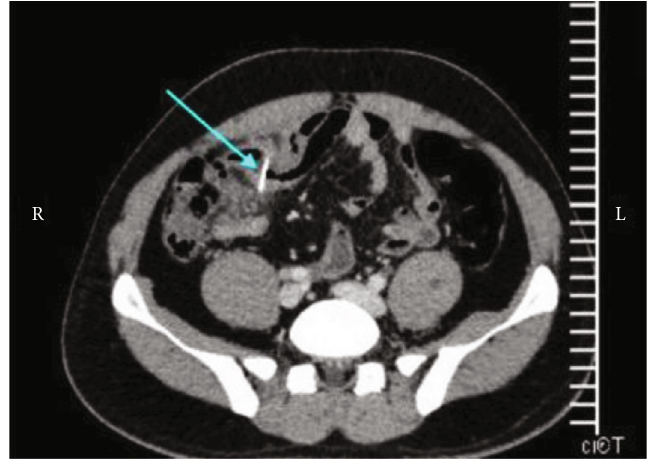
Figure 2: CT scan of case number 2 showing foreign body in the ileum (arrow).